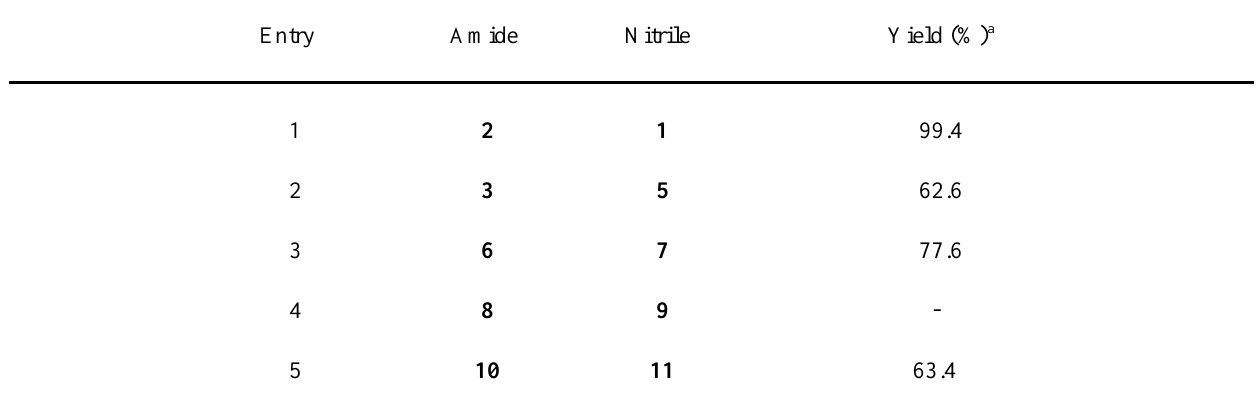
Table 1. Dehydration of heterocyclic carboxamides to the corresponding